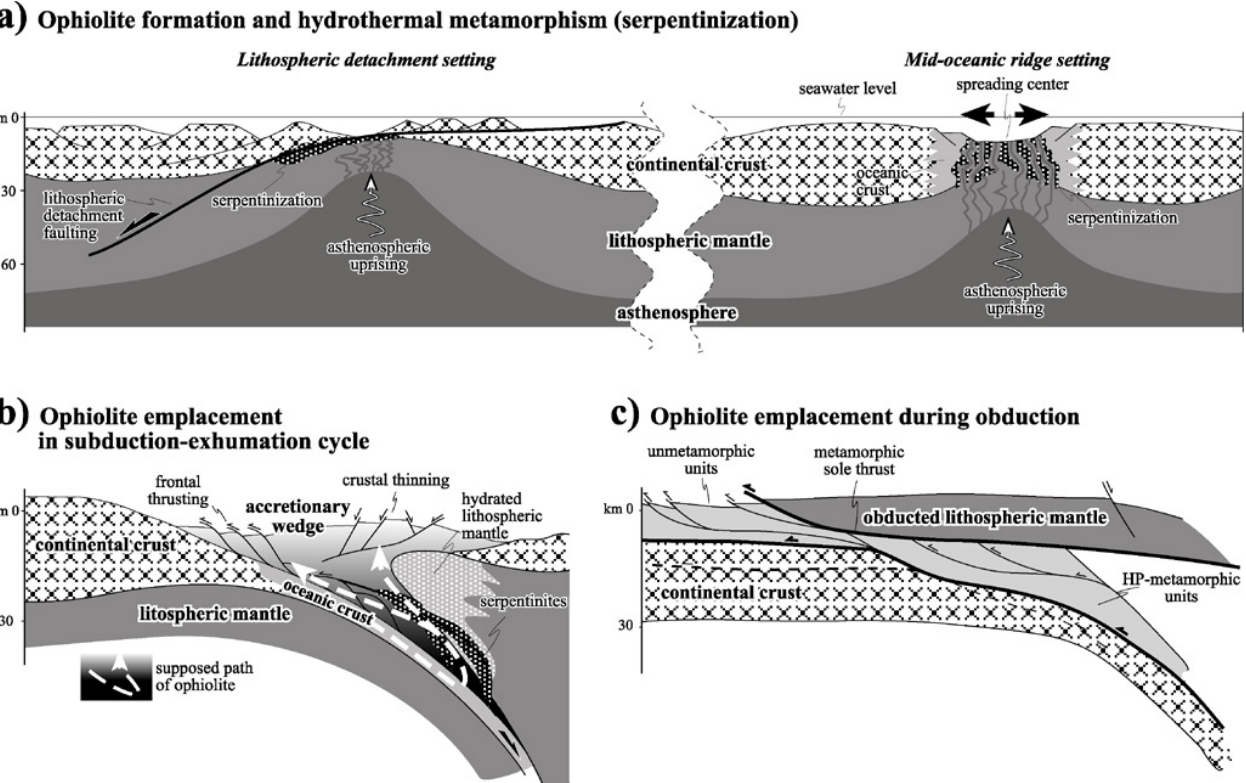
Fig. 2. Schematic scenarios of tectonic settings for ophiolites. (a) Mantle exhumation and ophiolite formation during two main crustal mechanisms: lithospheric detachment (e.g. McKenzie and Bickle, 1988, redrawn and modified) and coaxial stretching at the mid-oceanic ridge (e.g. Whitmarsh et al., 2001, redrawn and modified). (b) Subduction-exhumation setting illustrating possible tectono-metamorphic events experienced by ophiolites (after Agard et al., 2009, redrawn and modified). (c) Ophiolite obduction along a regional-scale metamorphic sole thrust (after Searle et al., 2003, redrawn and